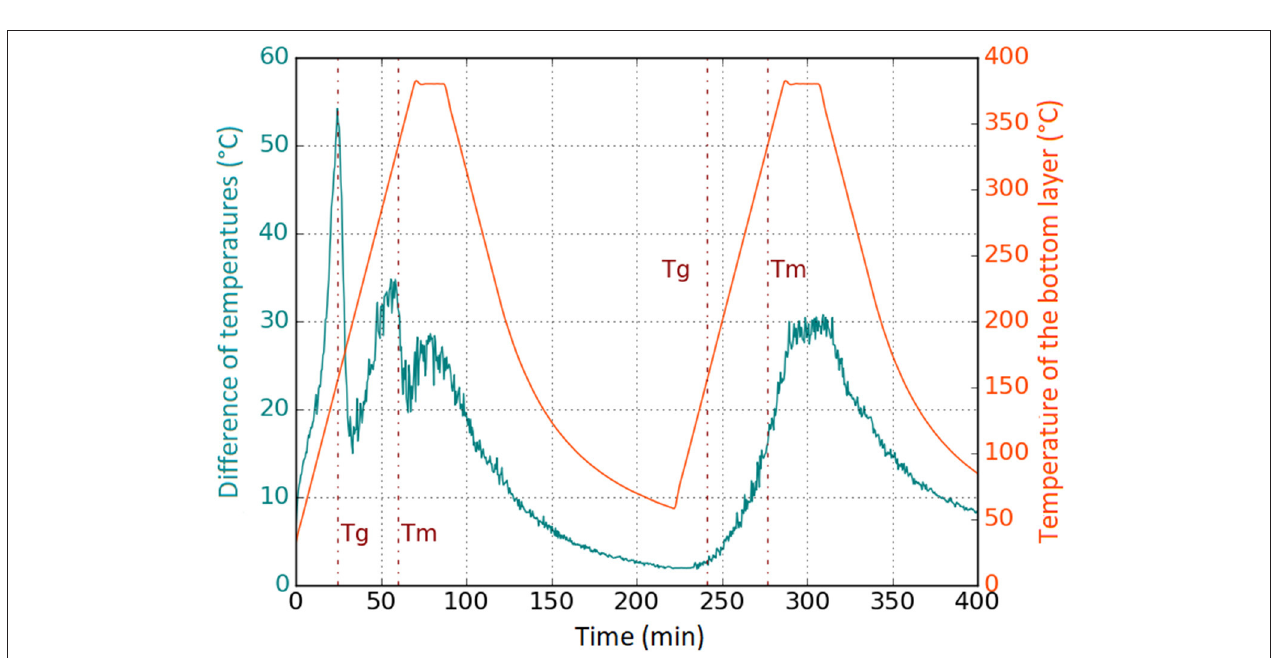
FIGURE 6 | Result of temperature difference for two successive consolidation